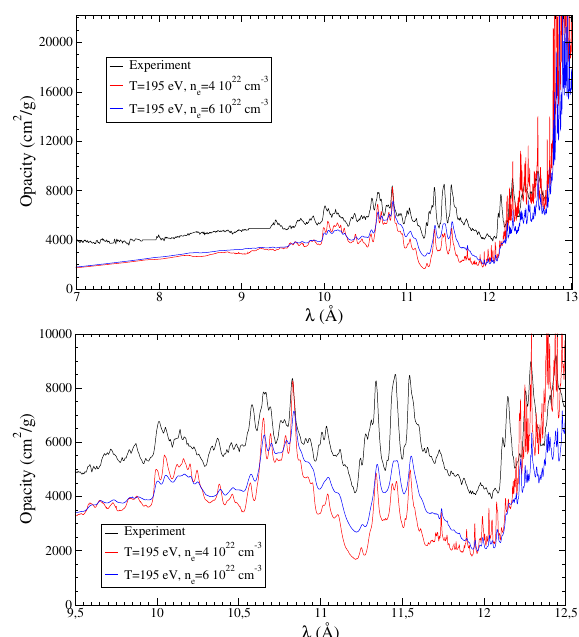
Figure 14. Effect of density on the iron opacity at T =195 eV (SCO-RCG computations) between 7 and 13 Å ( upper ) and focusing on 2 p → 4 d lines in the range [ 9.5 − 12.5 ] Å ( lower ). The experimental spectrum is also represented